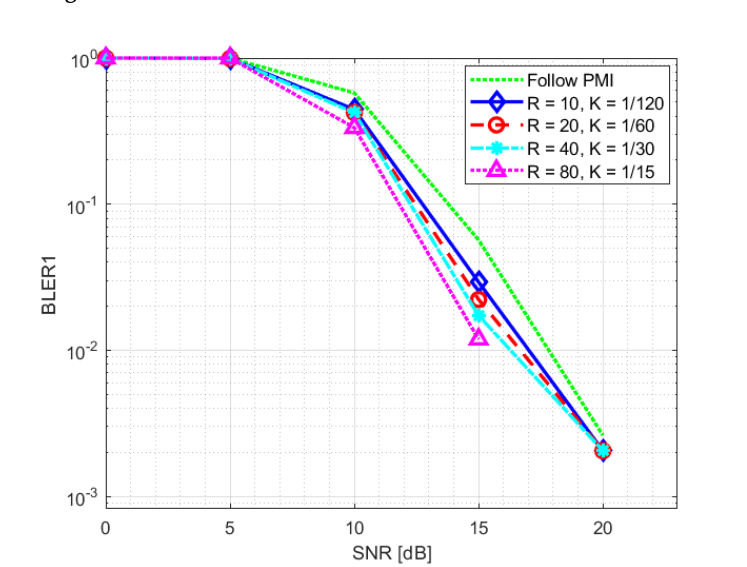
Figure 10. BLER1 statistics for NR-CsiNet model trained at SNR = 10 dB.